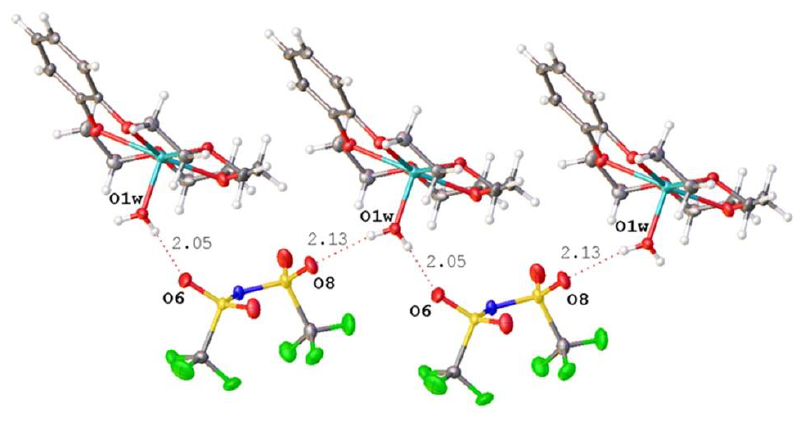
Figure 6. Chain formed by cations and anions due to hydrogen bonds O-H…O.